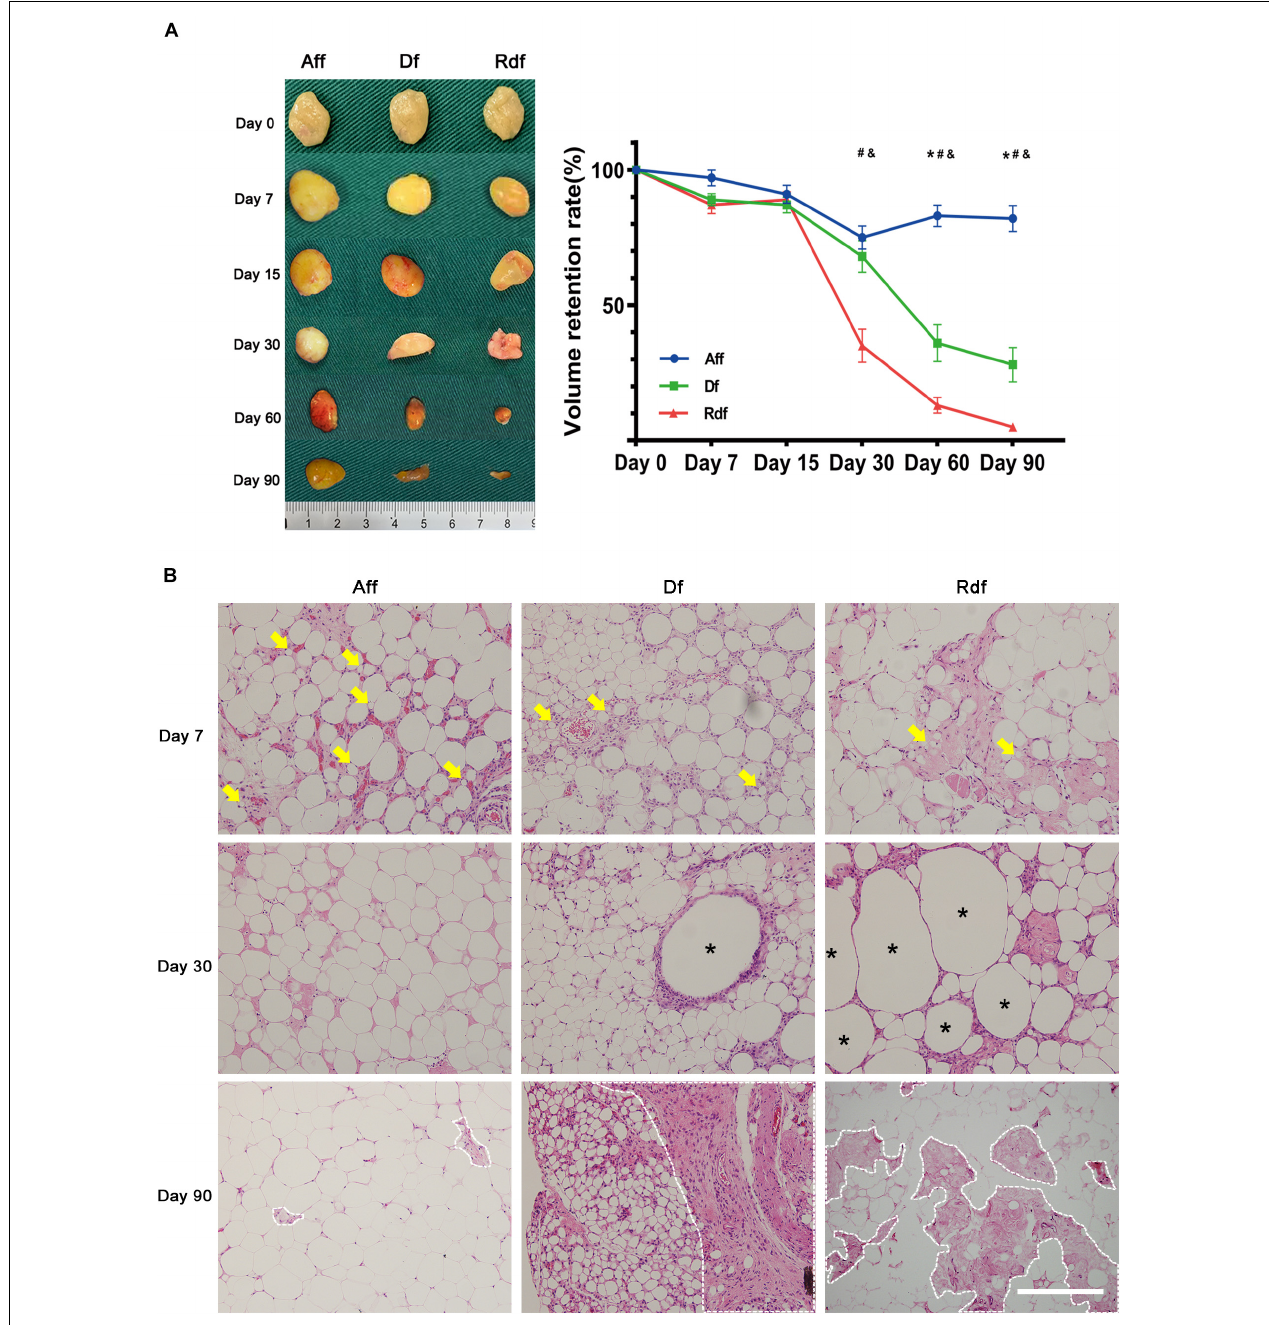
FIGURE 2 | Removal of SVF and microenvironment impairs graft retention. (A) Graft appearance and retention rates over time. Quantification of graft volume, showing significantly higher retention rates in the Aff group versus Df (* p < 0.05) or versus Rdf (# p < 0.05) at later time points. The retention rate of Df was significantly higher than Rdf on days 30, 60, and 90 (& p < 0.05). n = 5 mice. (B) Histological changes in Aff, Df, and Rdf grafts on post-operative day 7, 30, and 90. Some small preadipocytes with multiple intracellular lipid droplets (arrows) were observed as early as day 7. Large amounts of necrotic tissue and large oil cysts (asterisks) were observed in the interior zone of Df and Rdf groups on day 30. Severe fibrosis was observed in the Df and Rdf groups on day 90 (dotted line). Scale bar = 100 µ